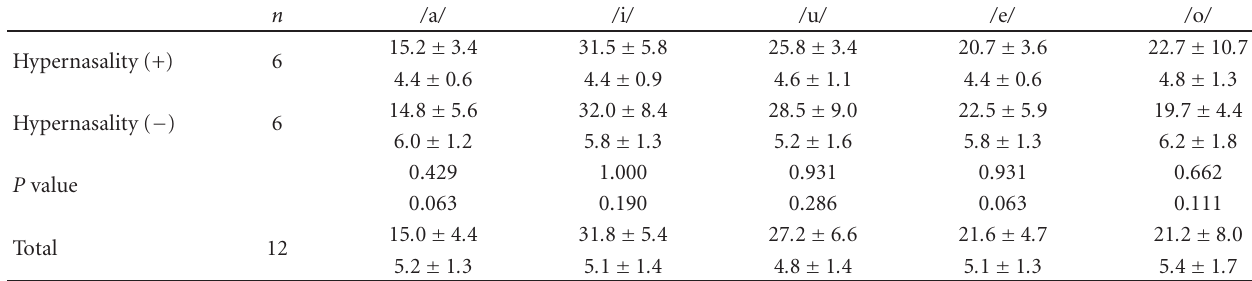
Table 1: First zero-crossing points of autocorrelation and estimated embedding dimensions.